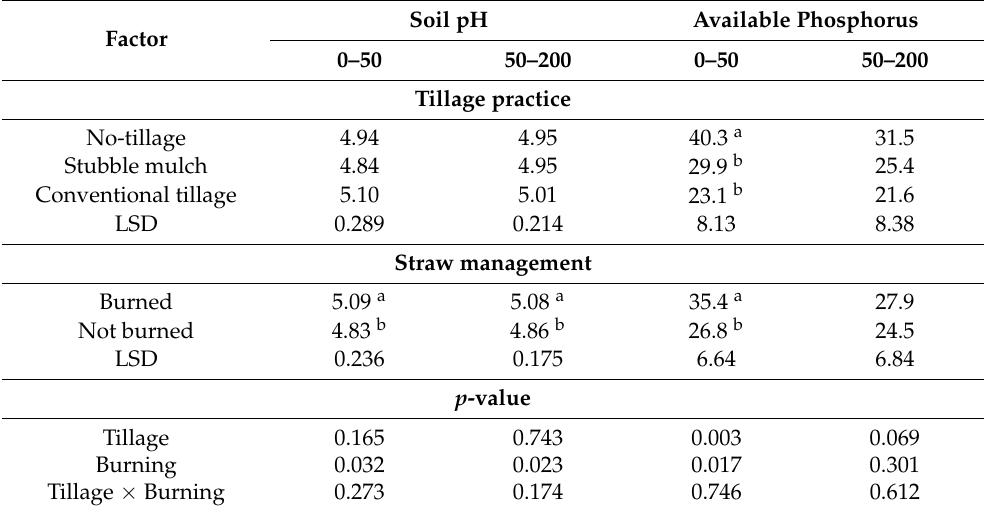
Table 4. The effects of tillage and straw management on soil pH and Bray extractable phosphorus in the 0–50 and 50–200 mm